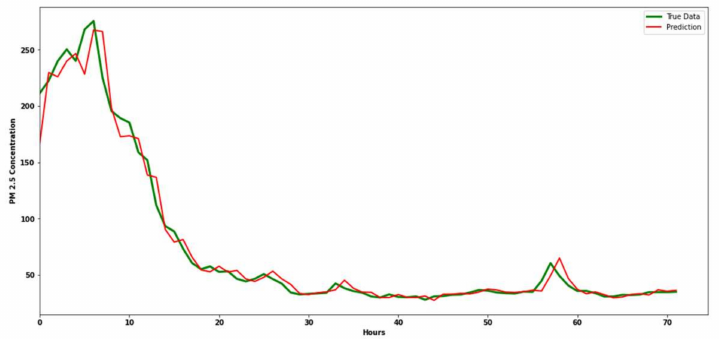
Figure 29. Forecasting for the next 72 h for Karachi using the LSTM encoder–decoder